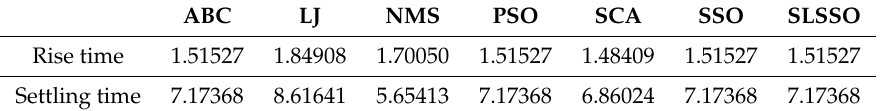
Table 7. Performance parameters using different algorithms for control loop II.